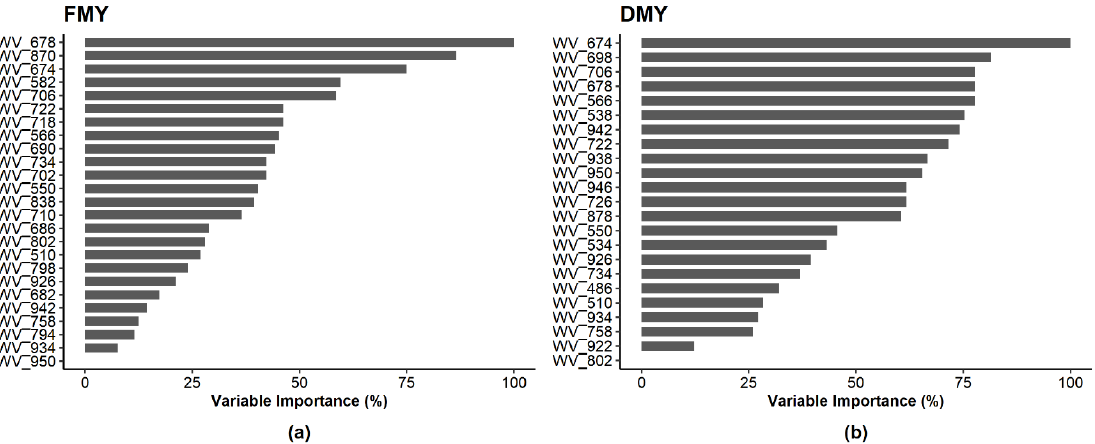
Figure 5. Variable importance of single wavelengths ( “ WV_XXX ” , given in nanometers) as selected by variable selection using random forests (VSURF) for ( a ) FMY and ( b ) DMY modeling with CBR. A total of 25 and 23 variables were selected for FMY and DMY, respectively.